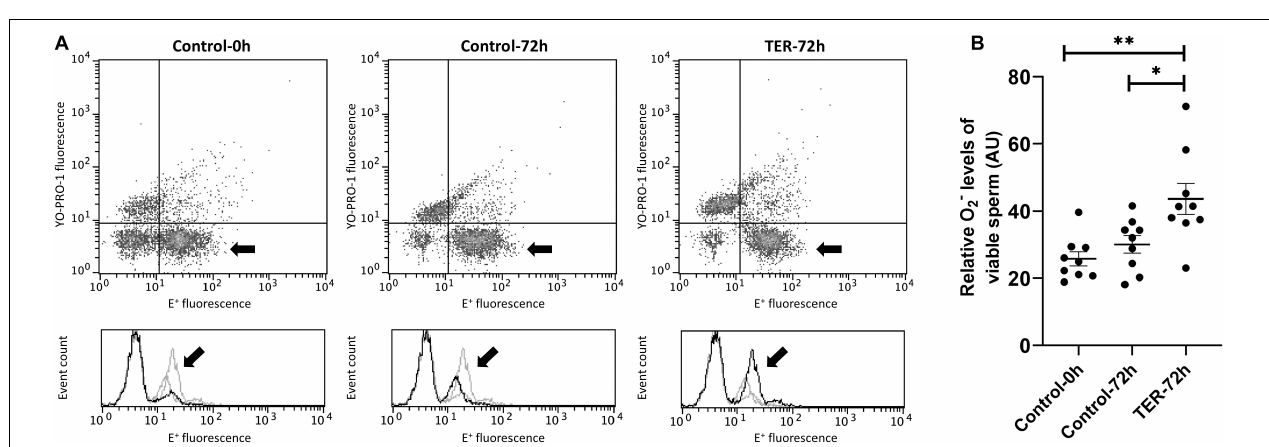
FIGURE 8 | Flow cytometry analysis of intracellular superoxide levels. (A) Representative flow cytometry dot plots of Yo-Pro-1 and ethidine (E + ) fluorescence and histograms showing the event count of E + fluorescence intensity of all treatments. Black arrows show the flow cytometry population selected for analysis represented in (B) . Dark gray lines in histograms show the event count of its corresponding treatment, whereas light gray lines show the event count of the remaining treatments. (B) Mean, standard error of the mean (SEM), and sample distribution of the relative E + fluorescence intensity of the viable sperm population in all treatments. Control-0h, semen samples at 0 h of storage; Control-72h, vehicle control (dimethyl sulfoxide; DMSO) semen samples at 72 h of storage at 17 ◦ C; TER-72h, semen samples treated with 100 µ M ezatiostat (TER) for 72 h of storage at 17 ◦ C. Sample size ( n = 9). * p ≤ 0.05; ** p ≤